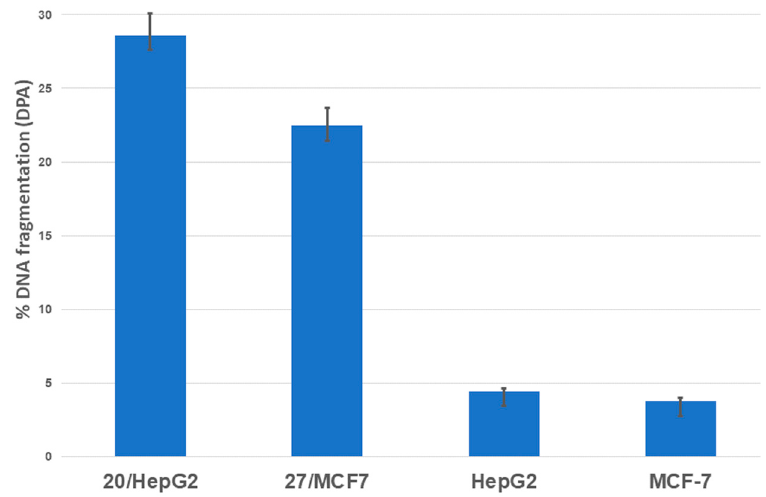
Figure 5. Statistical analysis of the DNA fragmentation percentage of MCF-7 and HepG2 cells after incubation with compounds 20 and 27 for 24 h IC 50 value. The data are reported as the mean ± SD of three independent experiments in triplicate.